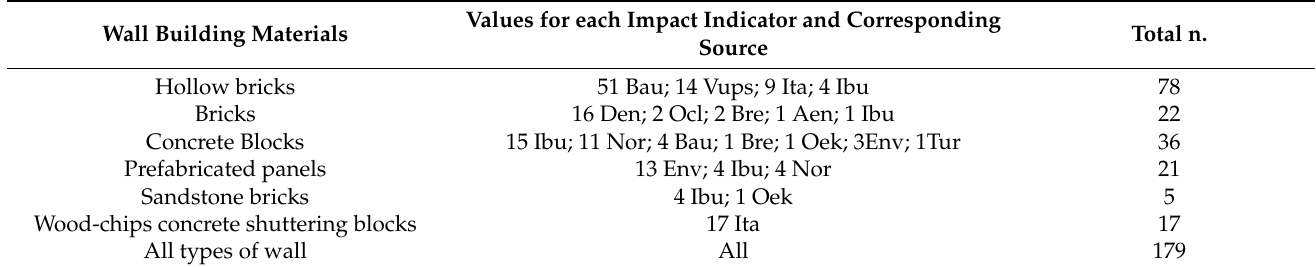
Figure 4. Typologies of construction blocks considered. Table 4. Wall blocks and total number of values collected for each impact